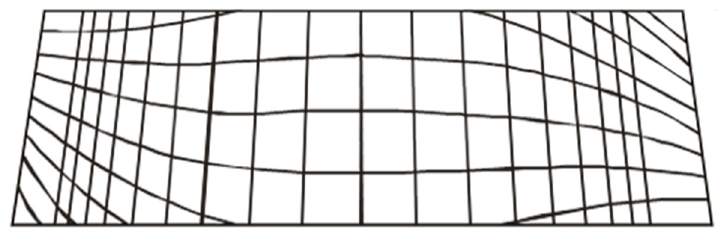
Figure 2. Corona image distortion model (adapted from Schneider et al. [30]).